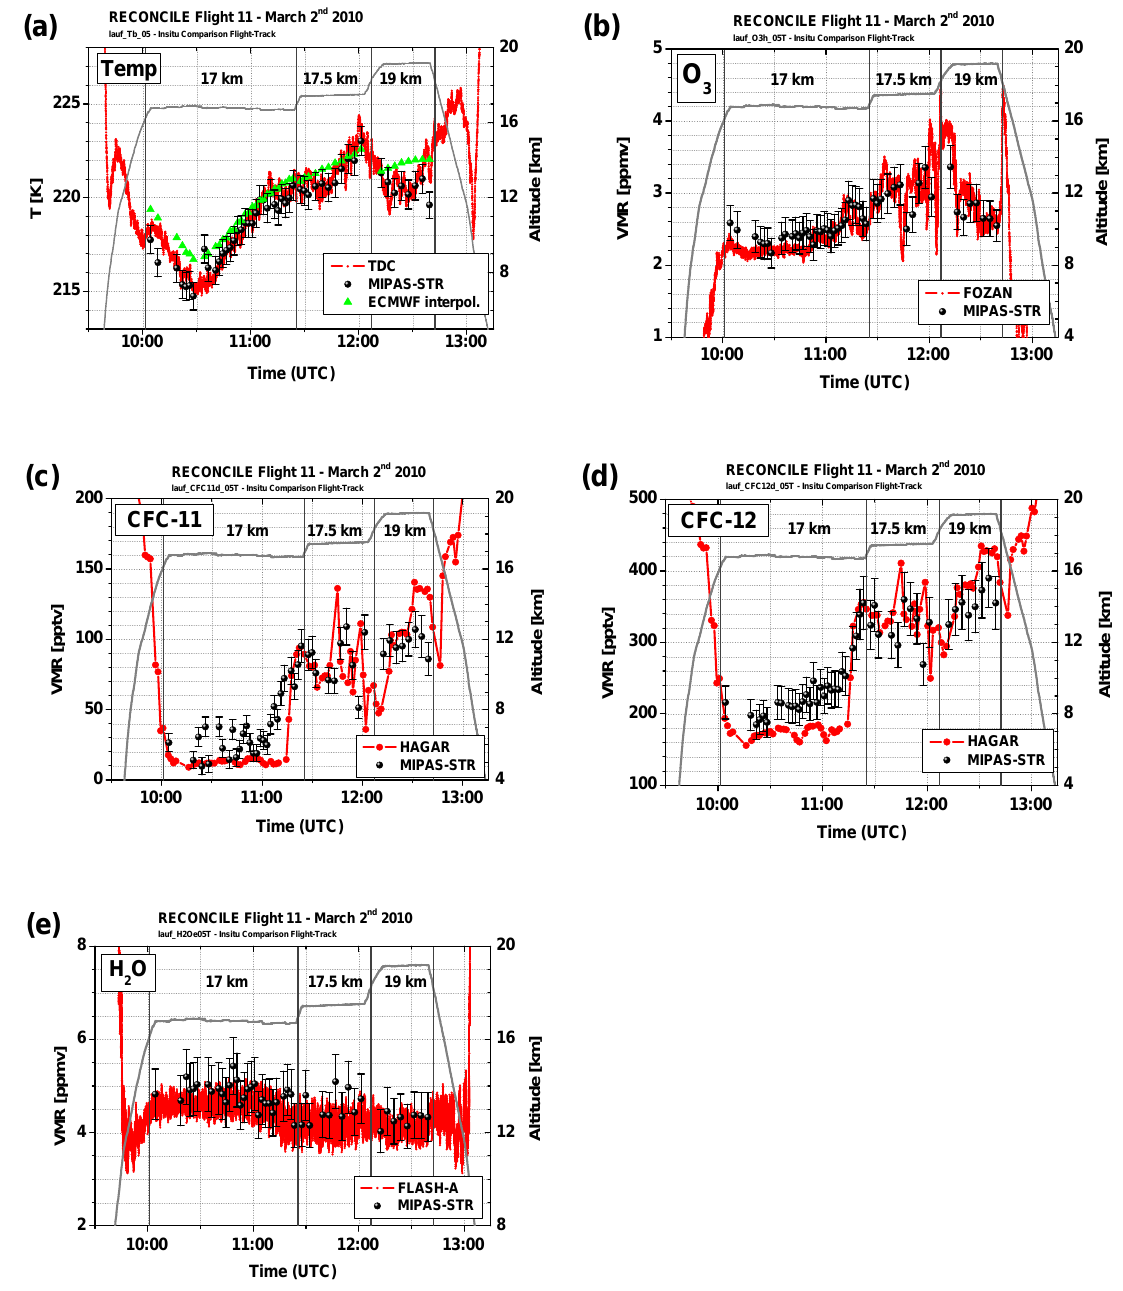
Fig. 16. (a–e) : Comparison of the retrieval results inclusive estimated error for temperature, O 3 , CFC-11, CFC-12 and H 2 O with in-situ measurements along flight track. Retrieval results are shown for the indicated retrieval-grid